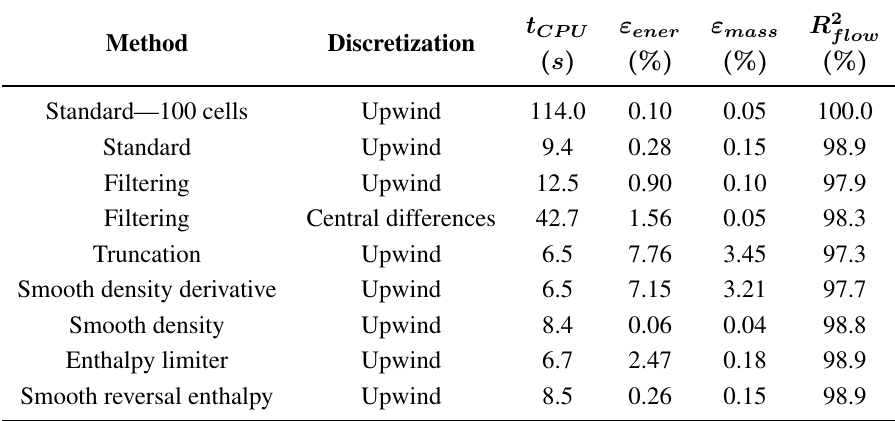
Table 3. Simulation results of the reversal